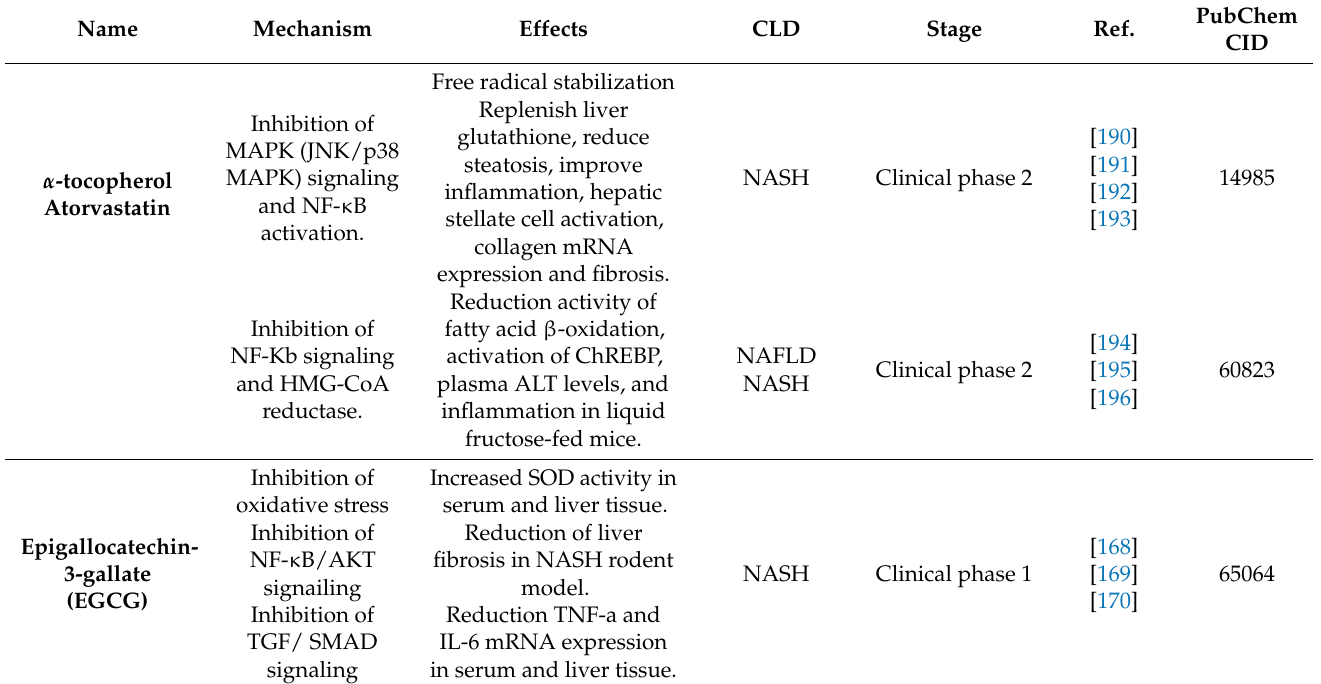
Table 1. Therapeutic compounds based on antioxidant properties in